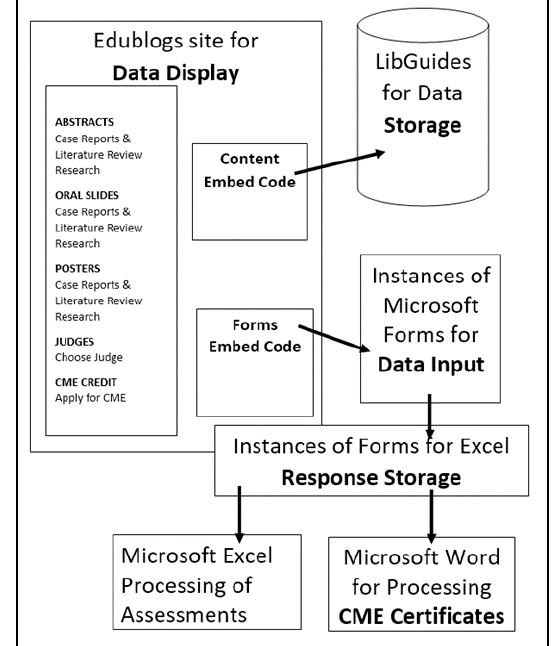
Figure 4 Design schematic of the